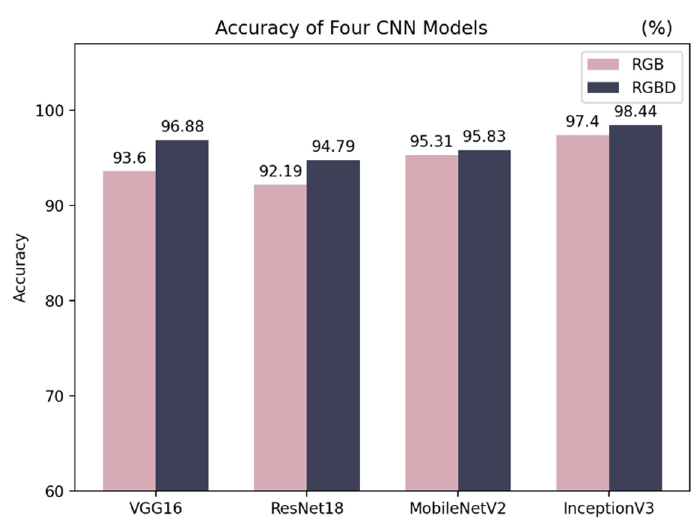
Figure 8. Comparison of CNN model performance on classifying the flower grades.